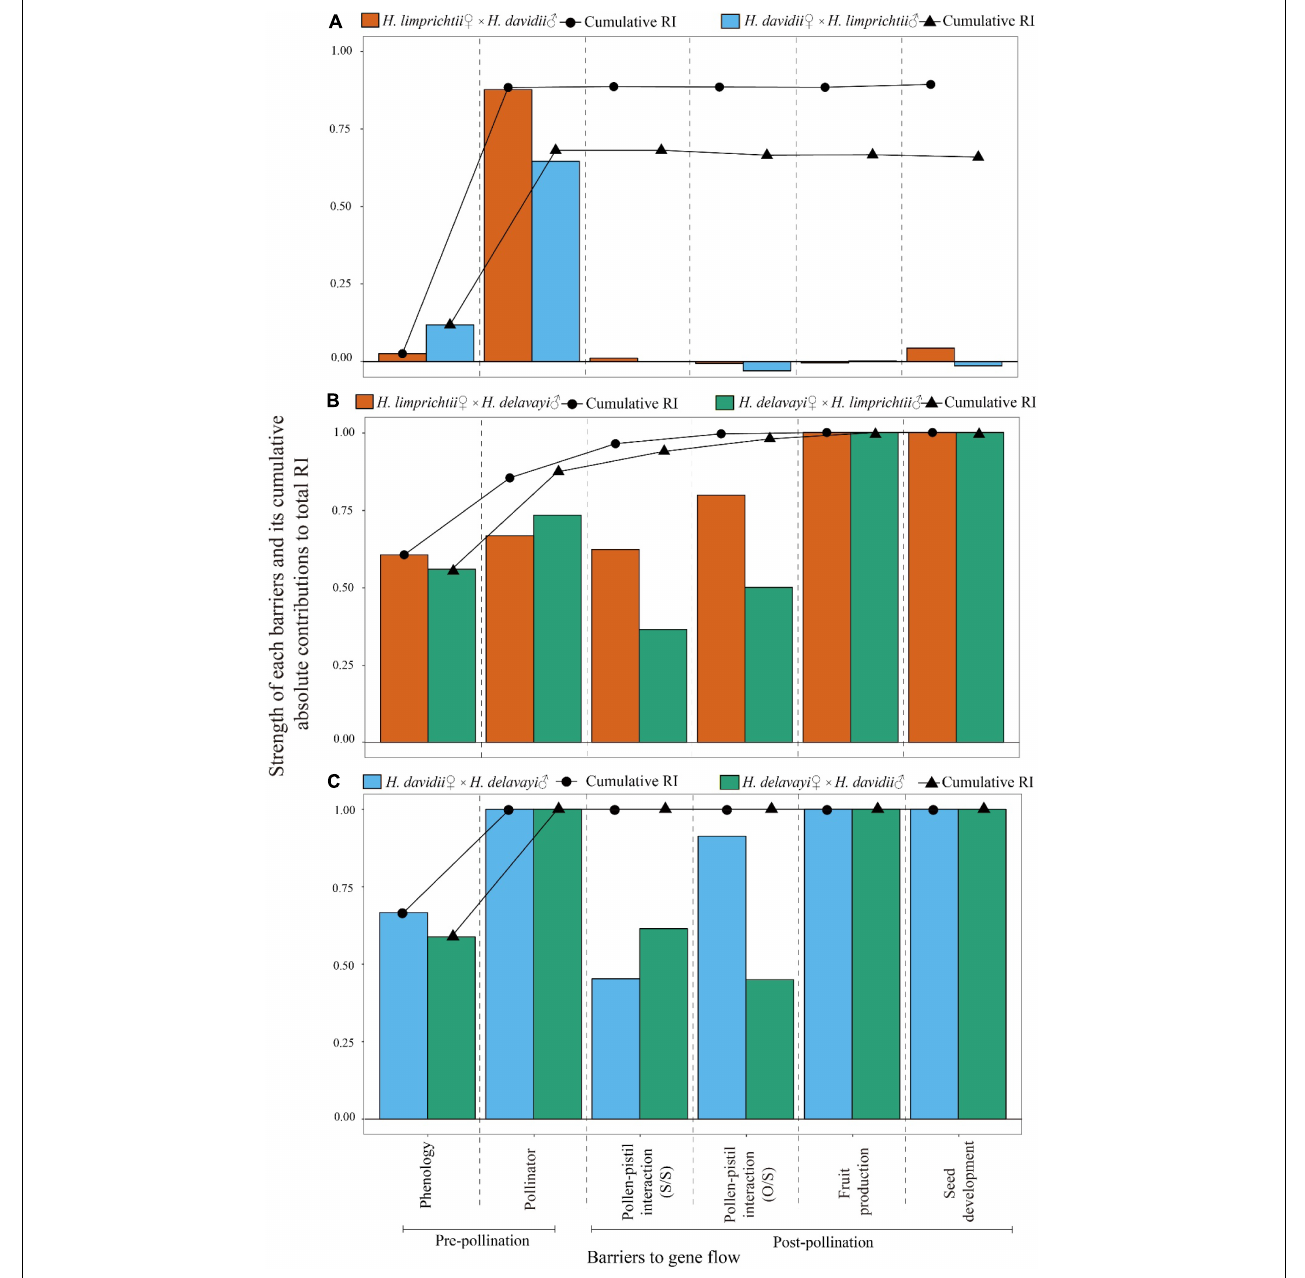
FIGURE 6 | Absolute contributions of six sympatric barriers to total isolation in reciprocal crosses between each of the three Habenaria species pairs. (A) Habenaria limprichtii and H. davidii , (B) H. limprichtii and H. delavayi , (C) H. davidii and H. delavayi following the method described in Sobel and Chen (2014). The line graph represents the cumulative contribution to RI of a mechanism after accounting for each of the investigated previous mechanisms. S/S, number of pollen tube entry into style/pollen germinated on the stigma; O/S, number of pollen tube entry into